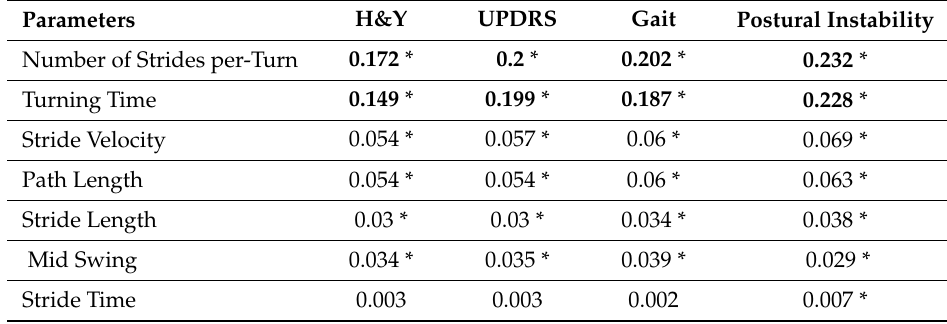
Table 2. ANOVA test: η 2 values for different parameters and clinical scores. Values with * correspond to p < 0.001. Bold font indicates values with strong effect